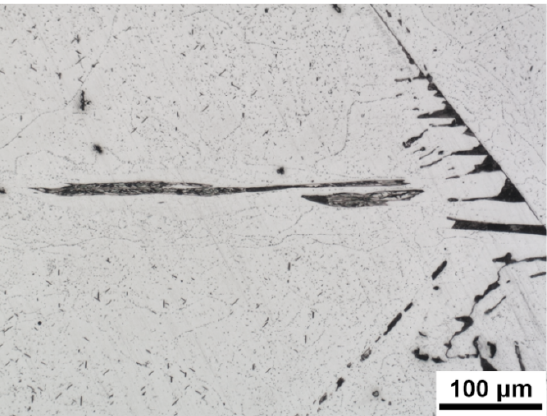
Figure 3. Straight high-angle δ-ferrite grain boundary with WA decomposition products occurring only in one ferritic grain. LM.